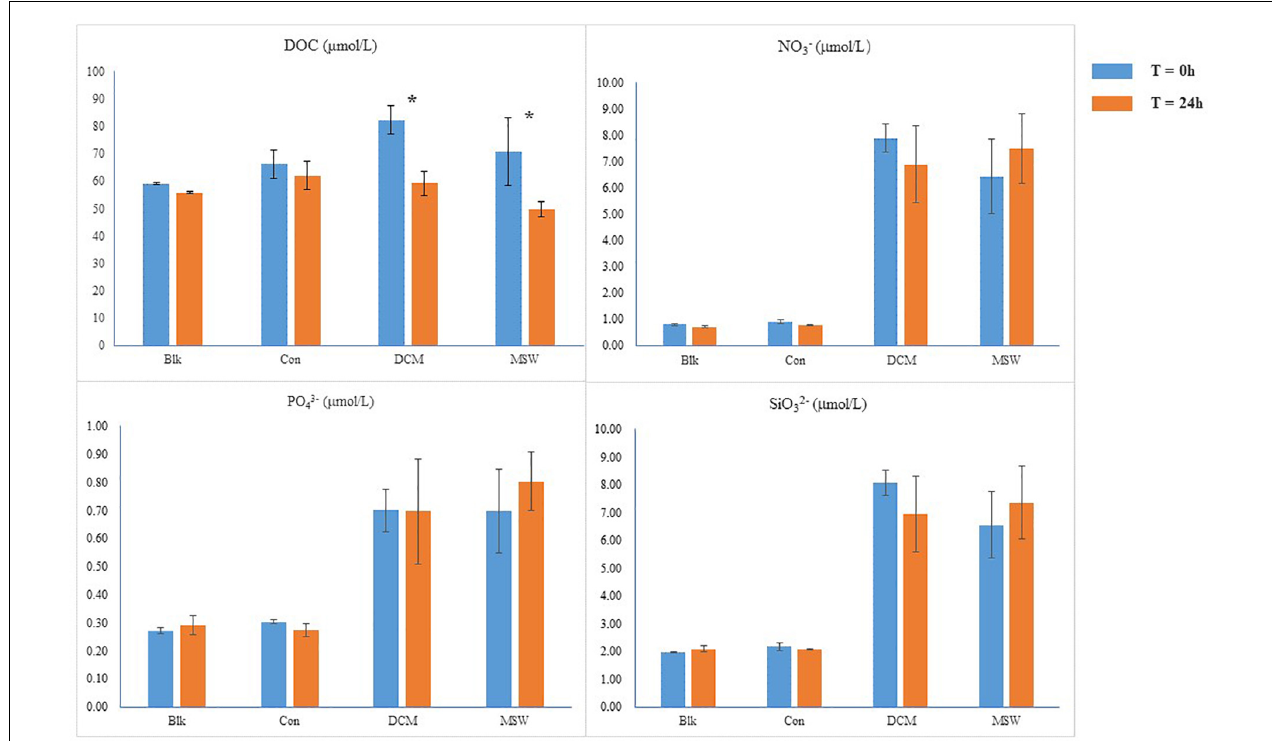
FIGURE 3 | Chemical parameters in each group; DOC, dissolved organic carbon; * indicates a significant difference.